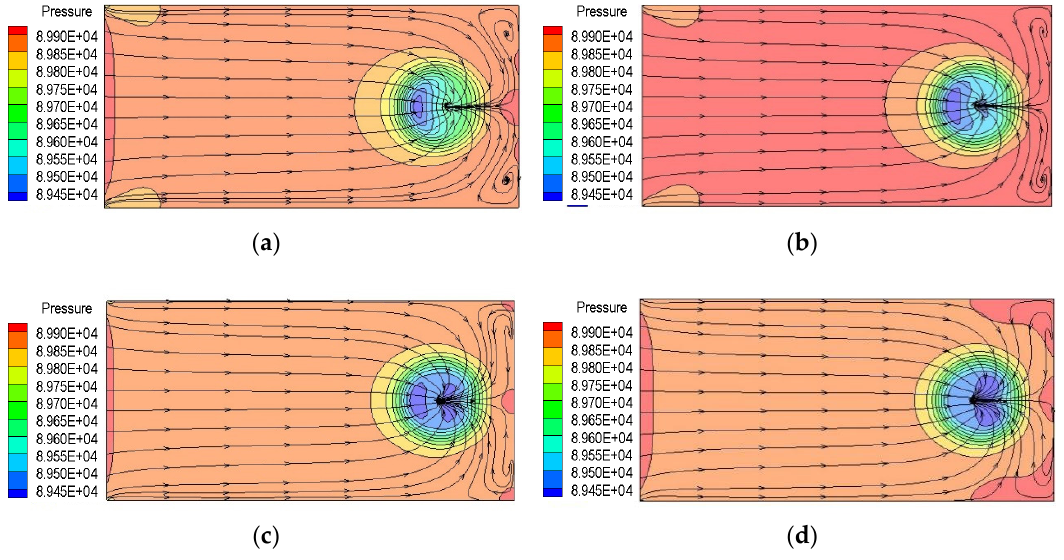
Figure 8. Pressure distribution of section 2-2 for different top floor height. ( a ) Case 1, ( b ) Case 2, ( c ) Case 3 and ( d ) Case 4.